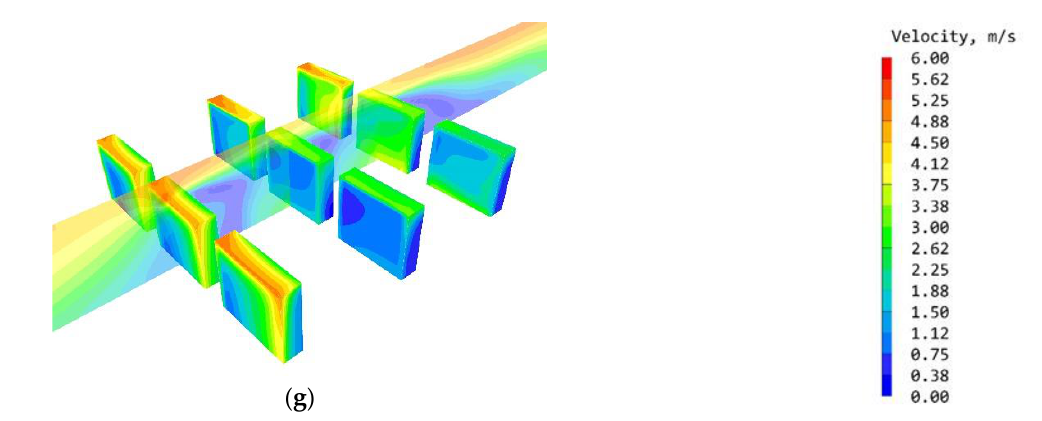
Figure 8. Three-dimensional air velocity map for seven building distribution patterns. ( a ) North side high (1-N), ( b ) east side high (1-E), ( c ) west side high (1-W), ( d ) east and north side high (2-EN), ( e ) west and north side high (2-WN), ( f ) east – west and north side high (3-EWN), and ( g ) uniform building height (UBH).